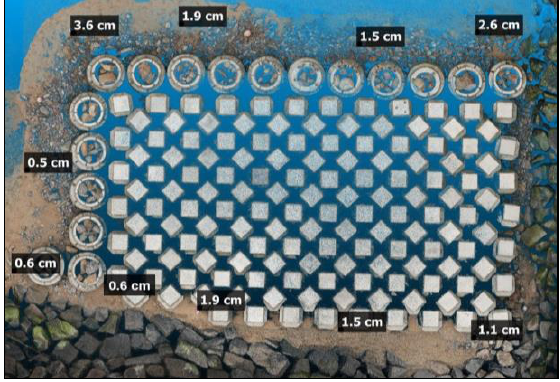
Figure 7. Georeferencing errors on each of the ten targets